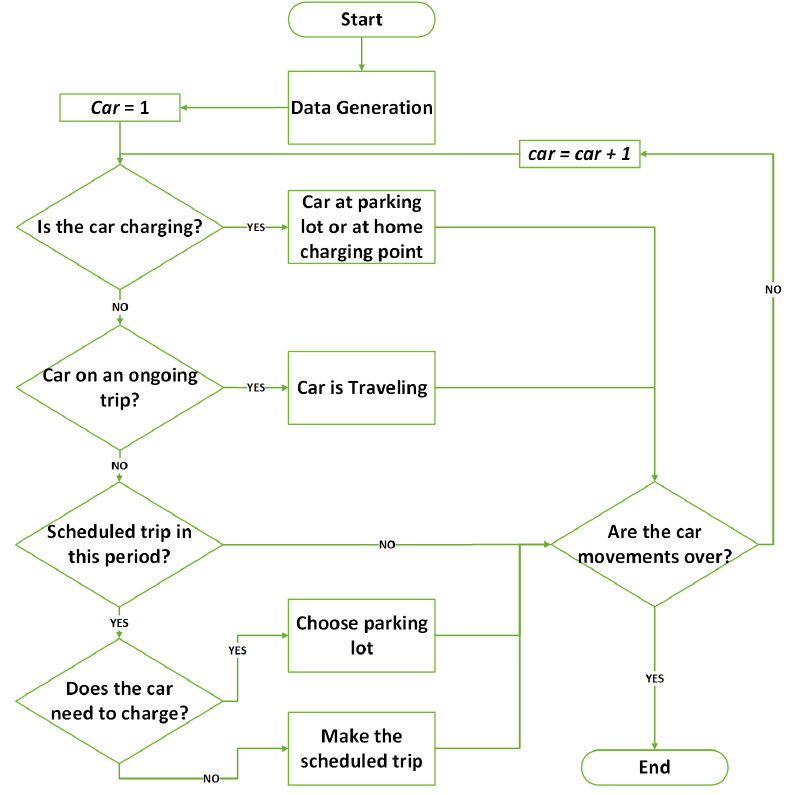
Figure 2. Flowchart for the EV users’ behavior